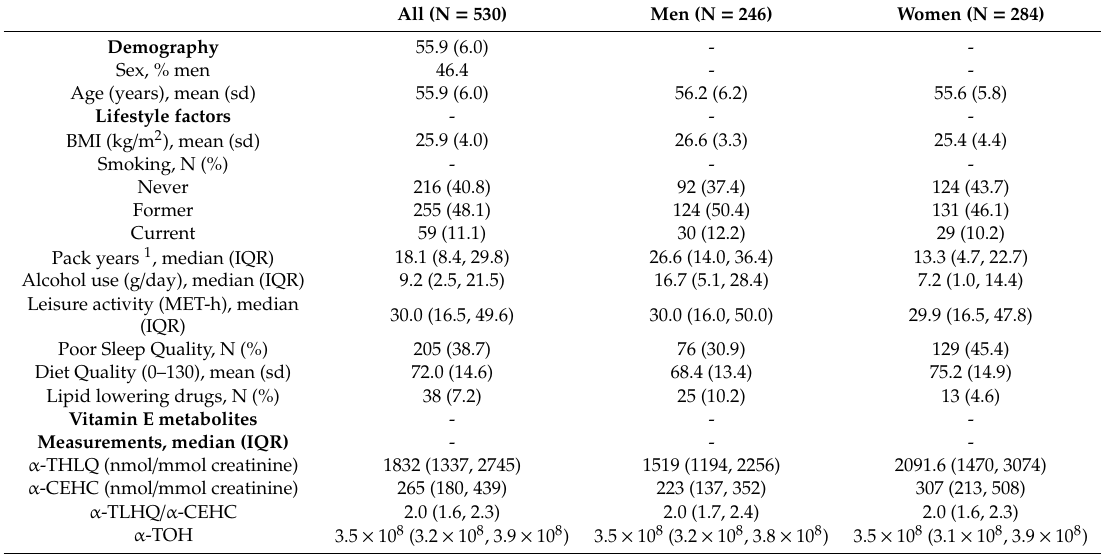
Table 1. Characteristics of the Netherlands Epidemiology of Obesity participants stratified by